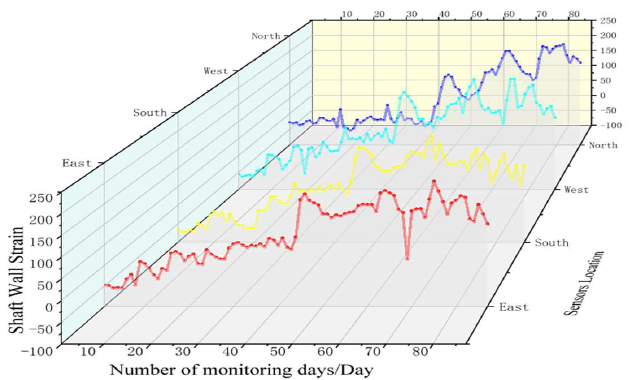
Figure 12. The FBG sensing strain diagram (396 m).